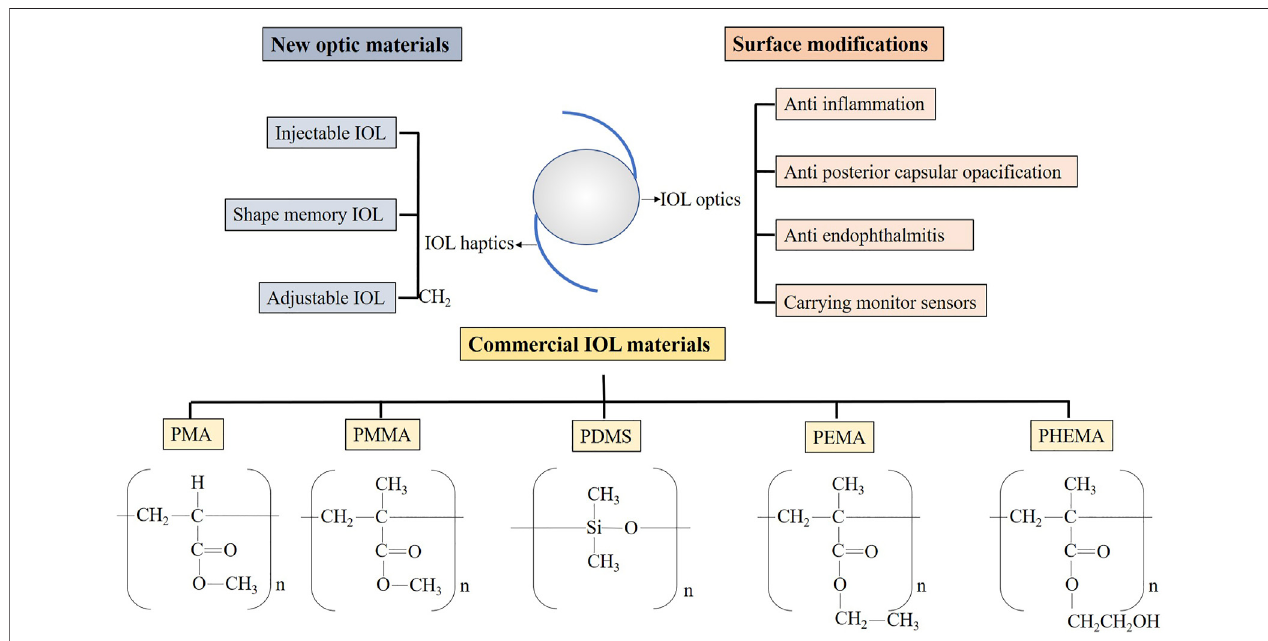
FIGURE 1 | The main outline of this review. PMA, polymethylacrylate; PMMA, polymethylmethacrylate; PDMS, polydimethylsiloxane; PEMA, polyethyl methacrylate; PHEMA, poly2-hydroxyethylmethacrylate.